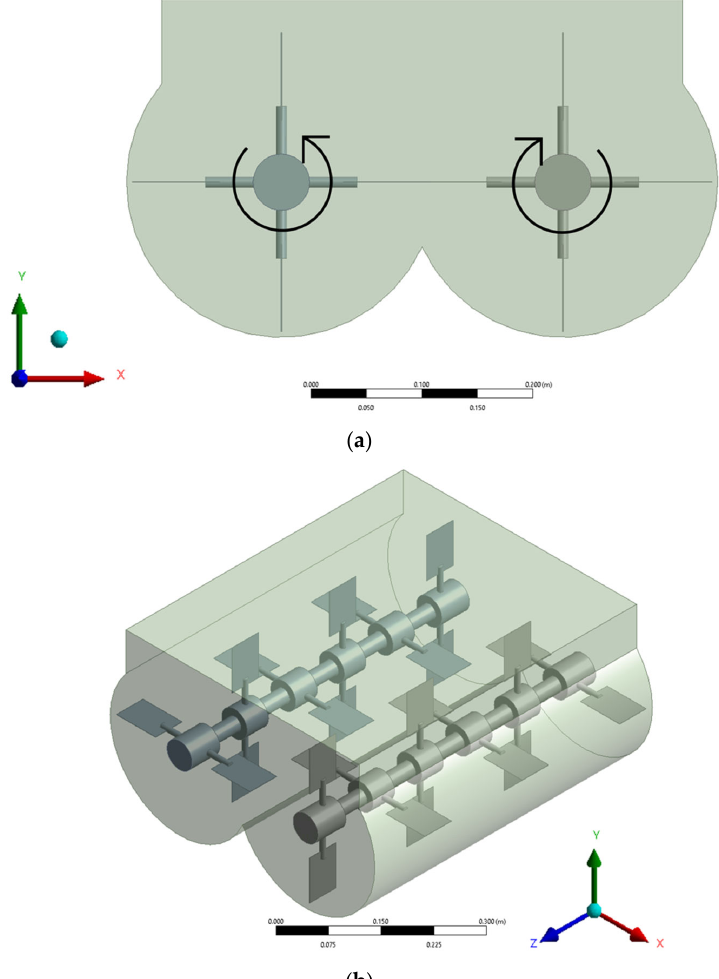
Figure 1. Mixer’s geometry used in the base case simulation; ( a ) Front view, and ( b ) Isometric view.